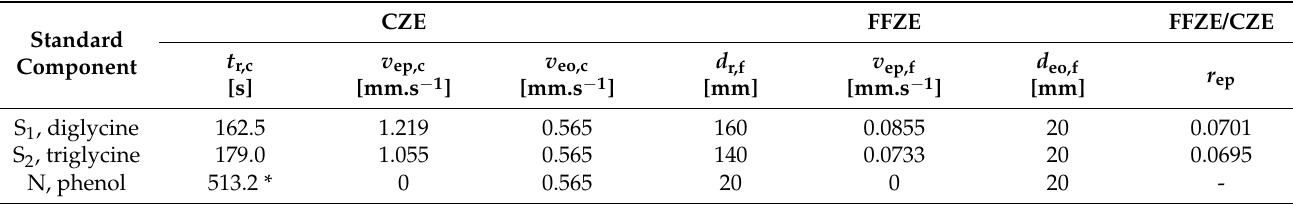
Table 1. Migration times, migration distances, electrophoretic and electroosmotic velocities of standard components, S 1 , diglycine, and S 2 , triglycine, and the electroosmotic flow marker, phenol, separated by CZE and FFZE.